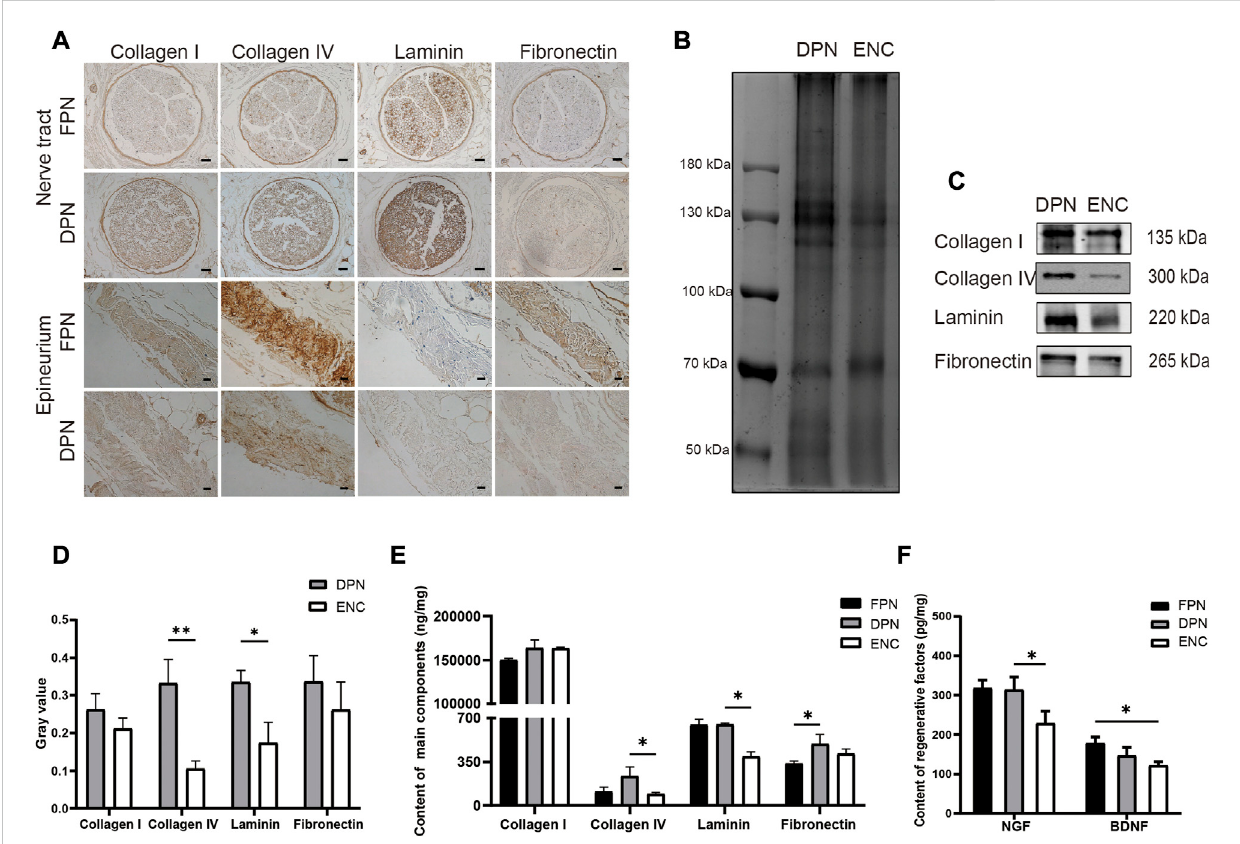
FIGURE 3 Comparison of main ECM bioactive molecules and regenerative factors in FPN, DPN, and ENC. (A) Immunohistochemical detection of collagen I, collagenIV,LN,and FNinFPNandDPN. (B) ThetotalproteinoftheDPN andENCgroups wasdetectedbyCoomassiebluestainingandused asacontrol forloading. (C,D) CollagenI,CollagenIV,LN,andFNweredeterminedbywesternblotandquanti fi edbygrayscaleanalysis. (E) CollagenI,CollagenIV,LN, and FN were quanti fi ed by ELISA in FPN, DPN, and ENC. (F) NGF and BDNF were detected by ELISA. For the nerve tract, scale bar = 50 μ m,